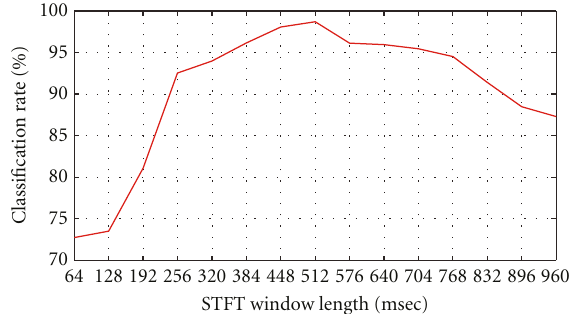
Figure 9: Classification rate with respect to the time resolution of the